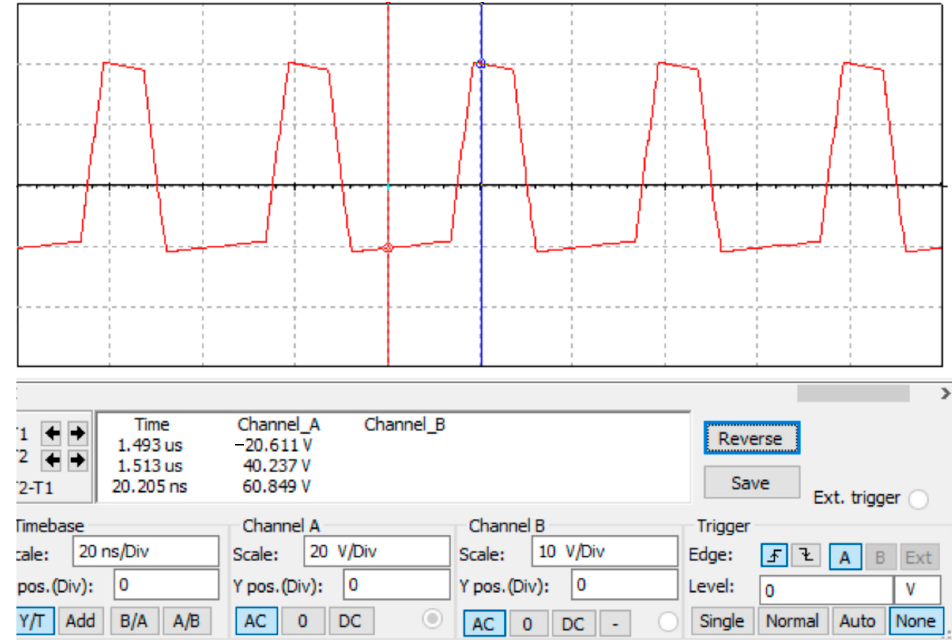
Figure 5. The simulation result of high-field asymmetric